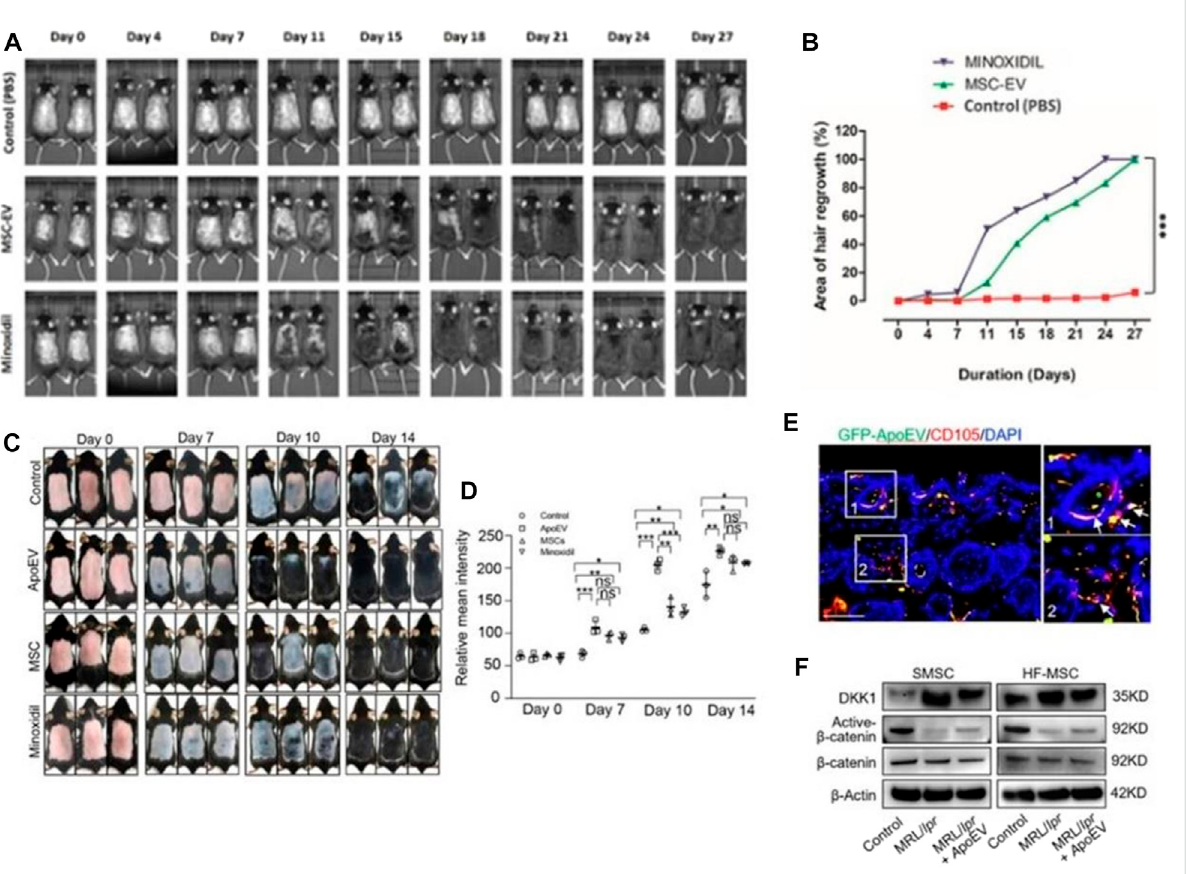
FIGURE 9 Hair regeneration induced by exosomes. (A, B) Take skin photos on days 0, 4, 11, 15, 18, 21, 24, and 28. Then, the hair regeneration area quantized by imageJ software is expressed in percentage (Rajendran et al., 2017). (C, D) Representative photos of mice showing skin color darkness and hair regrowth at 0, 7, 10 and 14 days post-injection. The level of pigmentation was quanti fi ed by the intensity of the darkness of the back skin in thesamearea. (E) Immuno fl uore-scentimagesshowthatGFP-ApoEV(green)wereengulfedbyskinMSCs(SMSCs)(1and2),asindicatedbyco- staining with CD105 at 7 days post-injection. (F) Western blotting shows Wnt/ β -catenin signaling is activated and DKK1 expression is decreased in SMSCs and hair follicle MSCs (HF-MSCs) from MRL/lpr mice after apoEVs injection (Ma et al.,